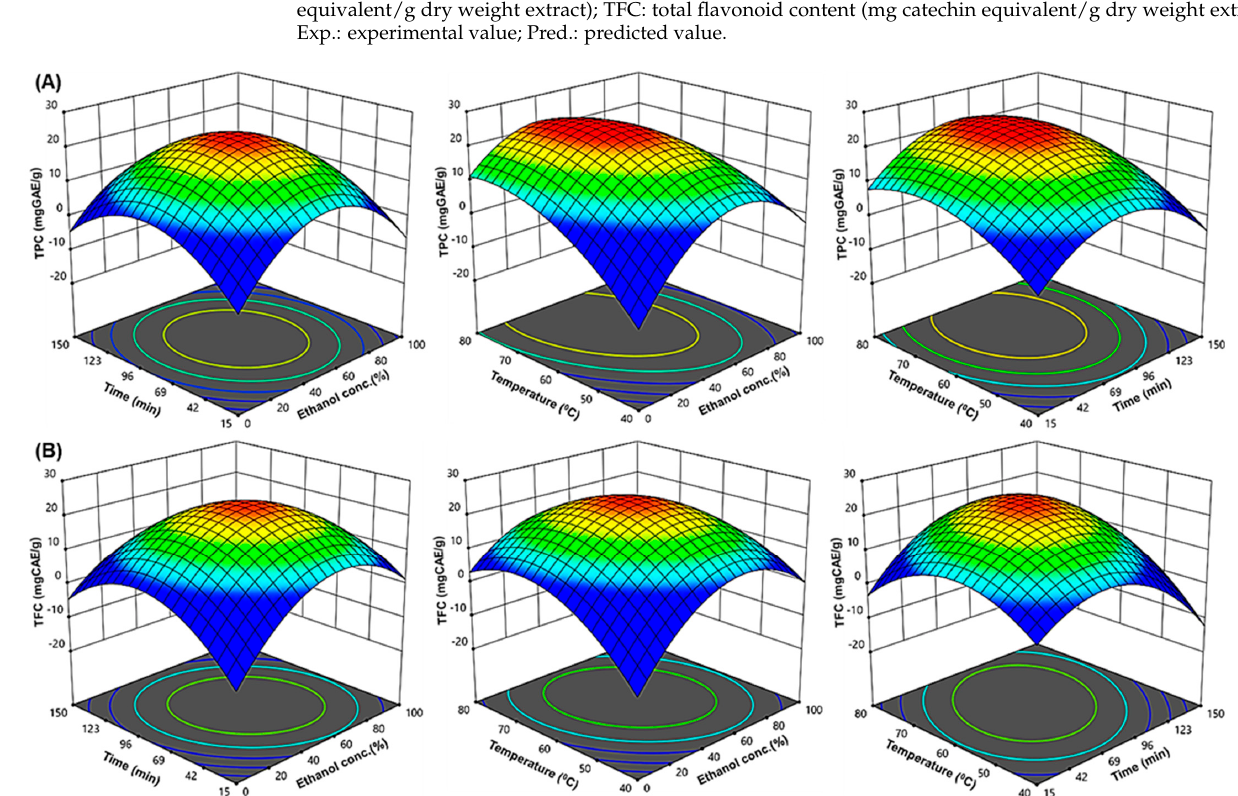
Figure 1. The three-dimensional (3D) response surface plots of URADP extraction for ( A ) TPC and ( B ) TFC for ethanol concentration, time, and temperature as a function of key interaction factors for RSM.